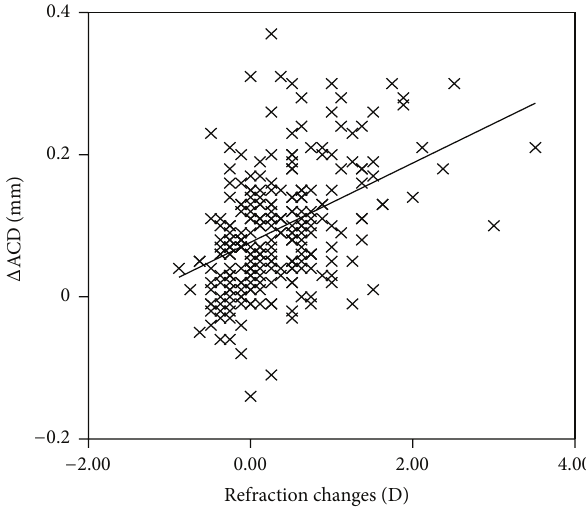
Figure 3: Association between the change of anterior chamber depth and the change of